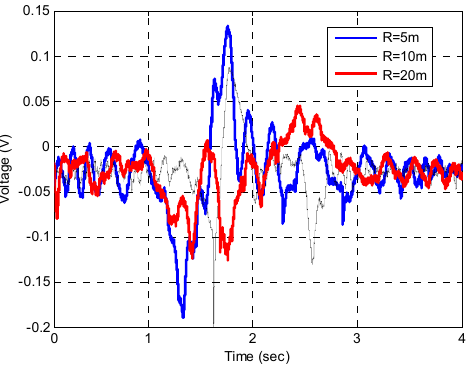
Figure 12. Signal in time at the ADC output for vehicle crossing at different crossing range, R R . Table 5. Vehicle’s category classification performance at different R R .